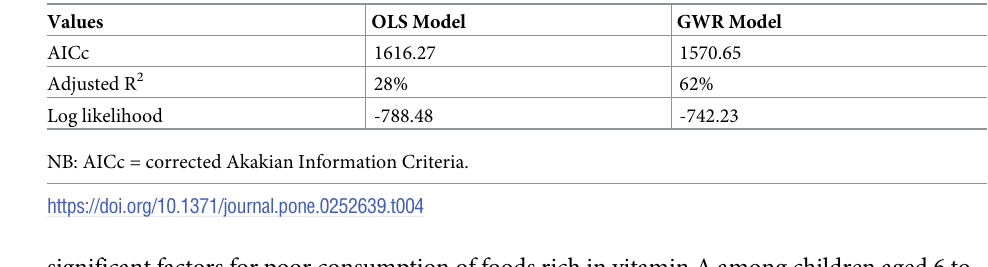
Table 4. Model comparison between the OLS and the GWR model.